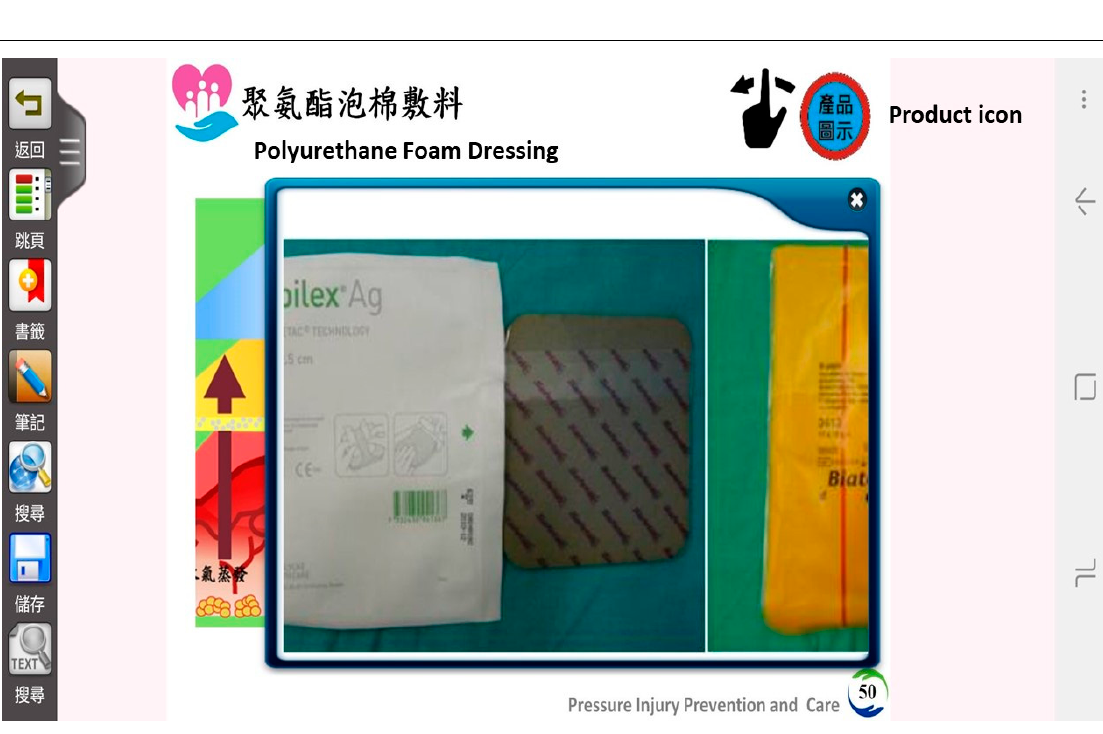
Figure A1. Pressure injury E-book